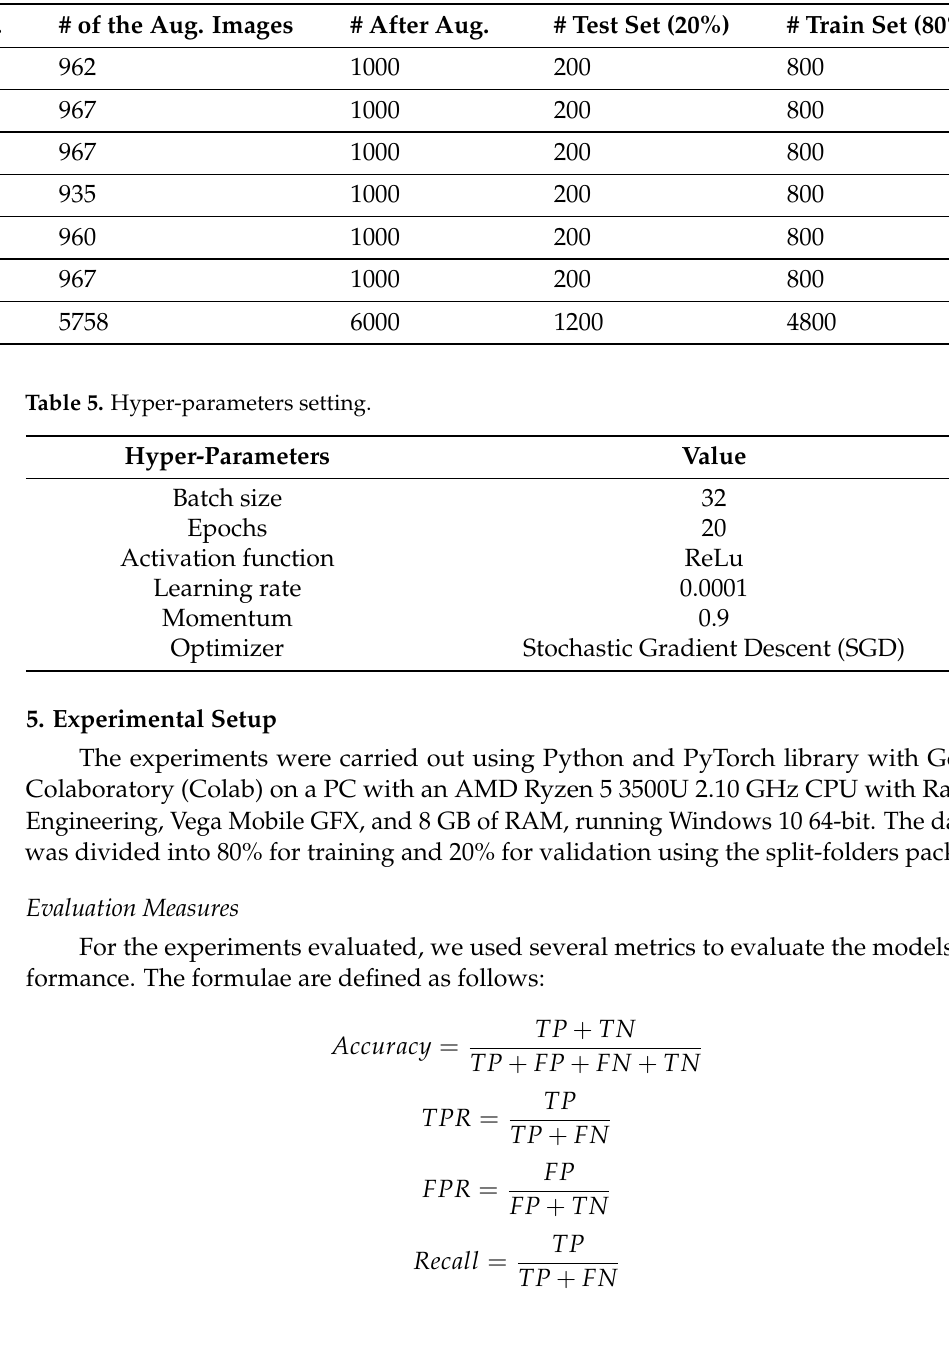
Table 4. Our dataset before and after augmentation techniques.